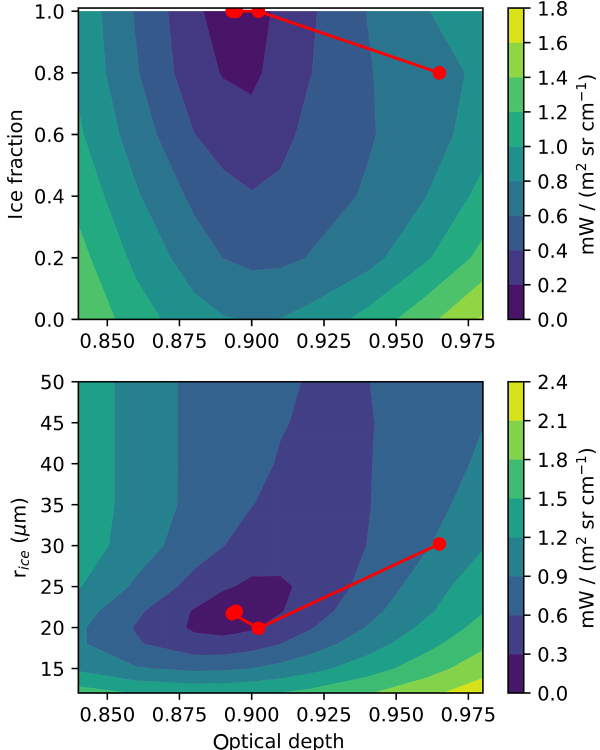
Figure 2. Error contours for retrievals of ice effective radius ( r ice ), ice fraction, and cloud optical depth, as root-mean-square error in radiances for an ice-only cloud. The retrieval trajectory (red line) and results for each iteration (red dots) are superimposed on the contour